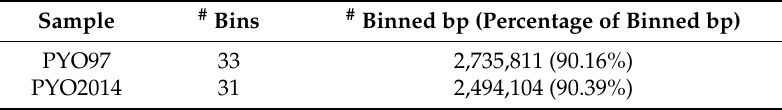
Table 3. Number of bins yielded by MetaBAT and number and percentage of binned bp out of the total number of bp in contigs larger than 2000